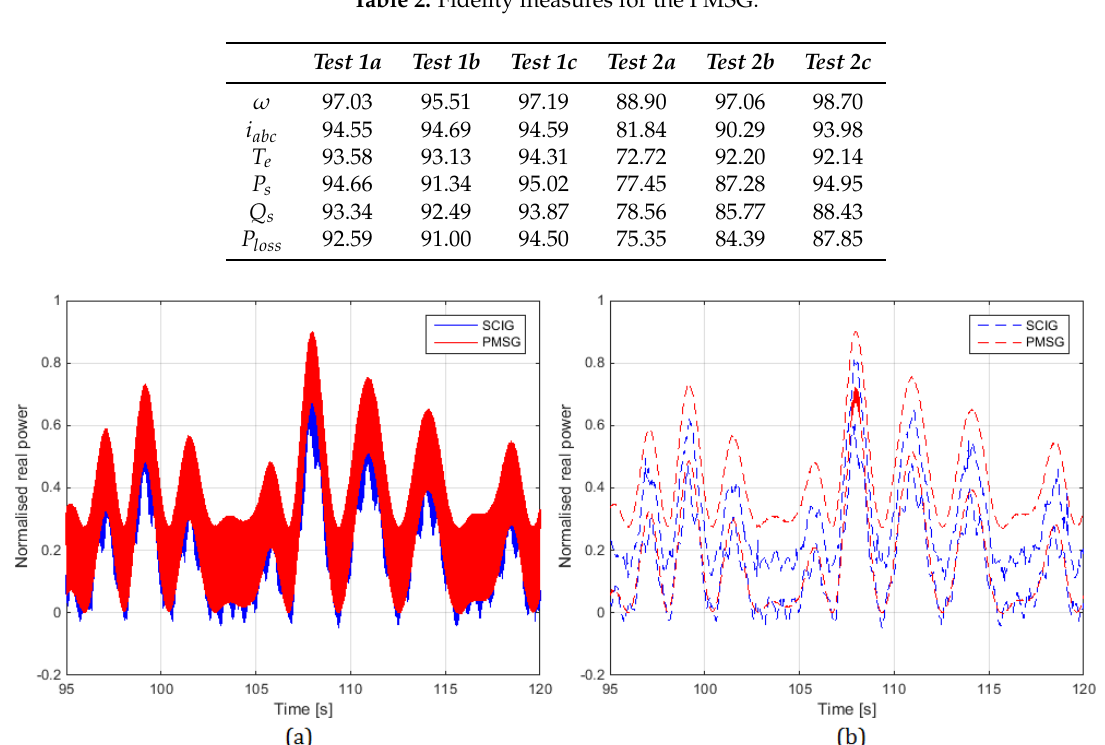
Figure 13. Frequency content of the stator voltage signals in Test2b from machine measurements and models results. Table 2. Fidelity measures for the PMSG.